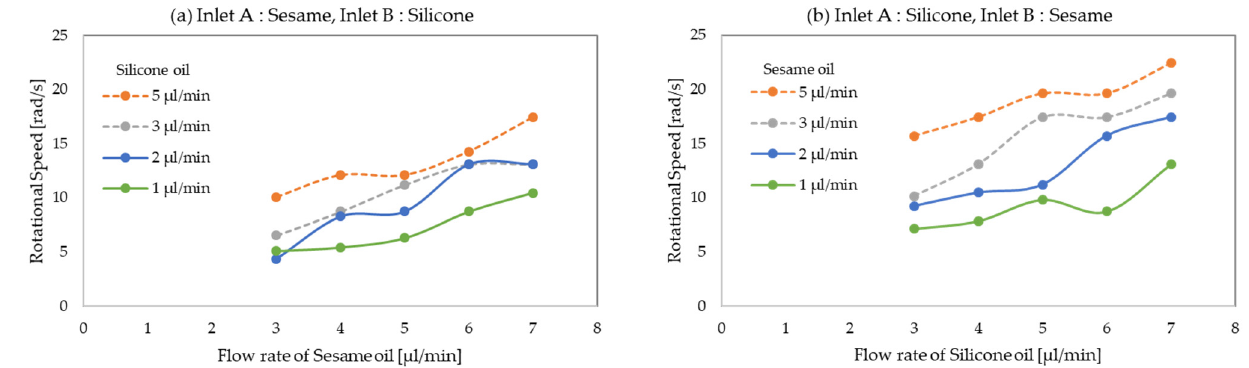
Figure 6. Rotational speed of droplet versus carrier oil flow rate, when the droplet. diameter was varied accordingly. ( a ) Clockwise rotation; ( b ) anti-clockwise rotation.